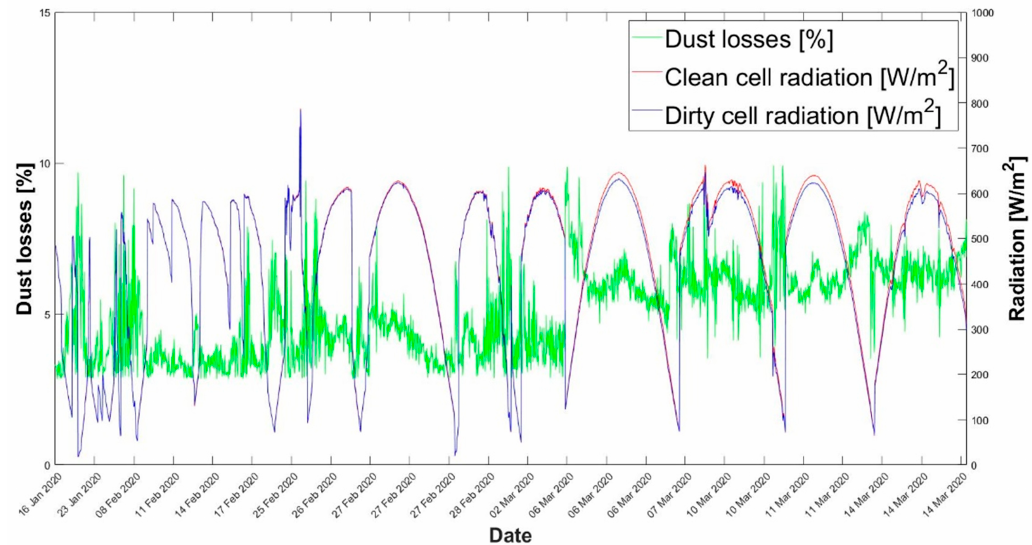
Figure 12. Variation in the production loss associated with dust and the incident radiation at the experimental plant during the measurement campaign.